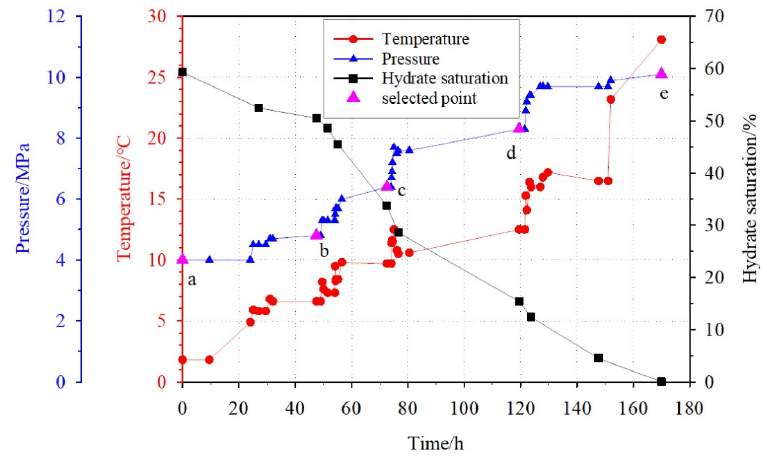
Figure 2. Variations in pressure, temperature, and hydrate saturation ( S h ) during hydrate dissociation.